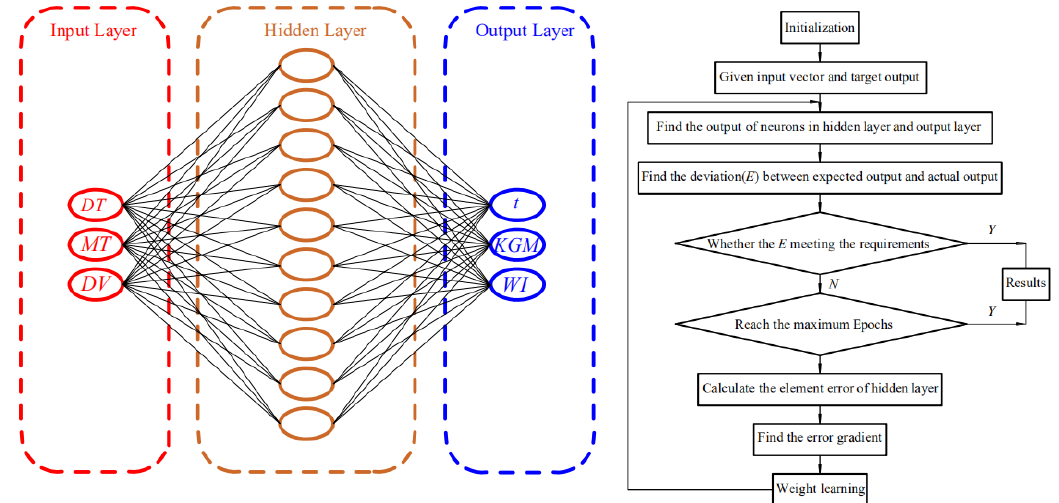
Figure 2. The established BP ( Back Propagation ) neuron network.